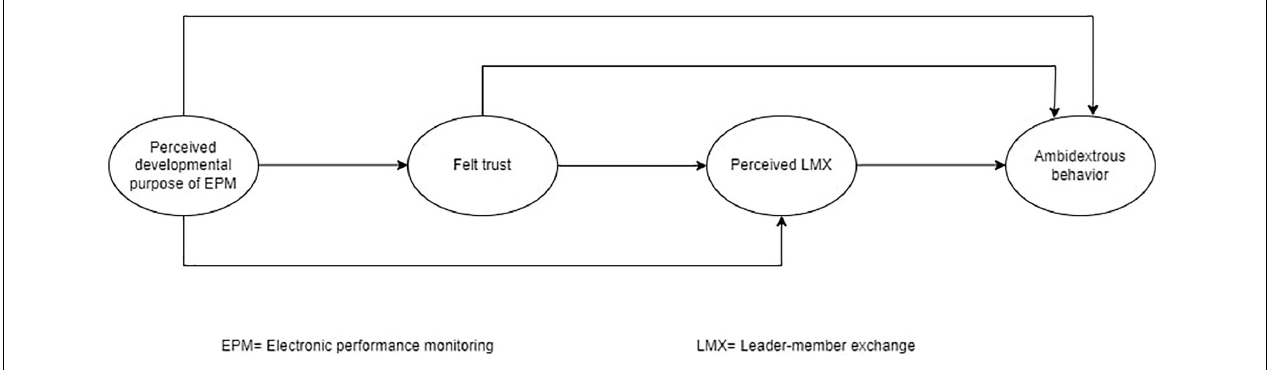
FIGURE 1 | Research